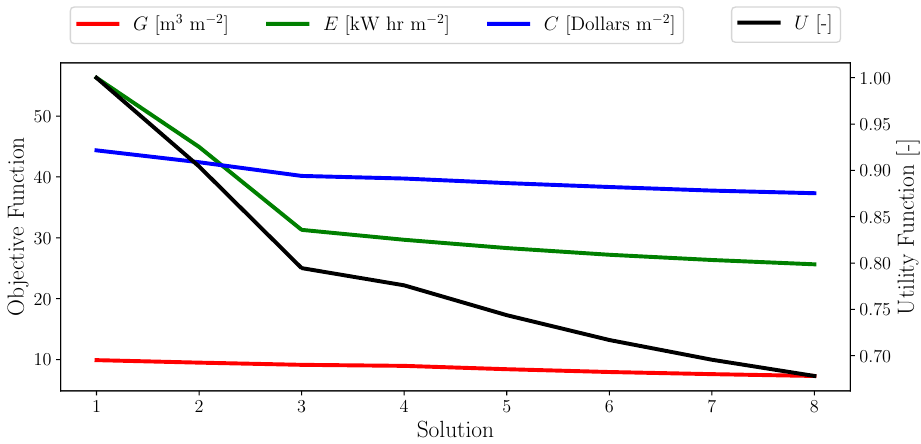
Figure 6. Pareto path of optimization process for objective and utility functions using 2D